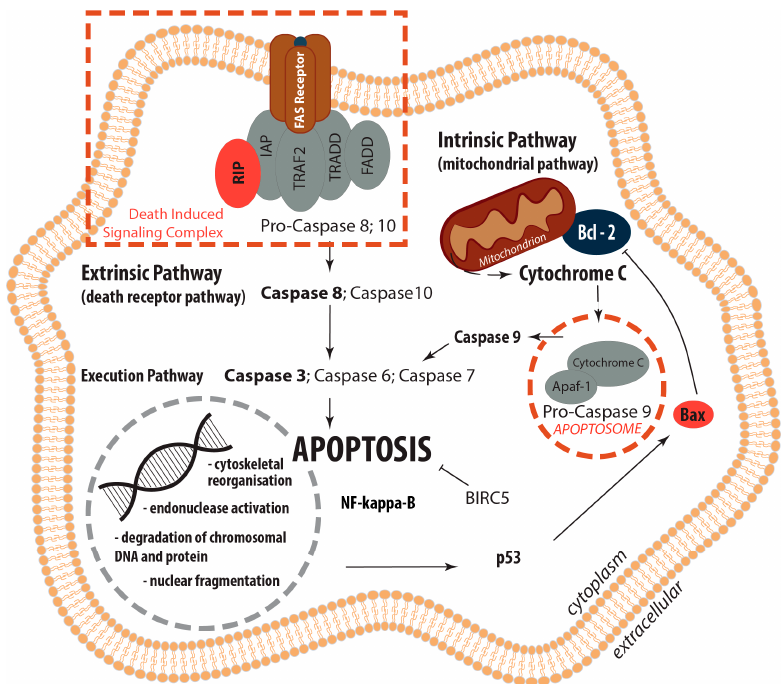
Figure 9. Overview: Regulation of Apoptosis. Extrinsic (death receptor pathway) and intrinsic (mitochondrial pathway) apoptosis pathways as well as their interplay within the common execution pathway are displayed.